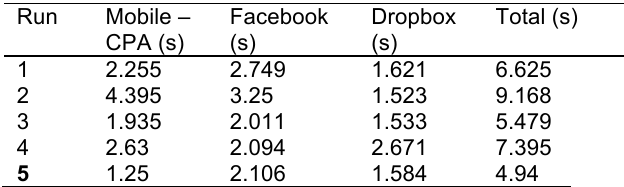
Table 1. The time in seconds over 5 runs to upload a 112KB image from the mobile device to the CPA, and subsequently from the CPA to Facebook and Dropbox.